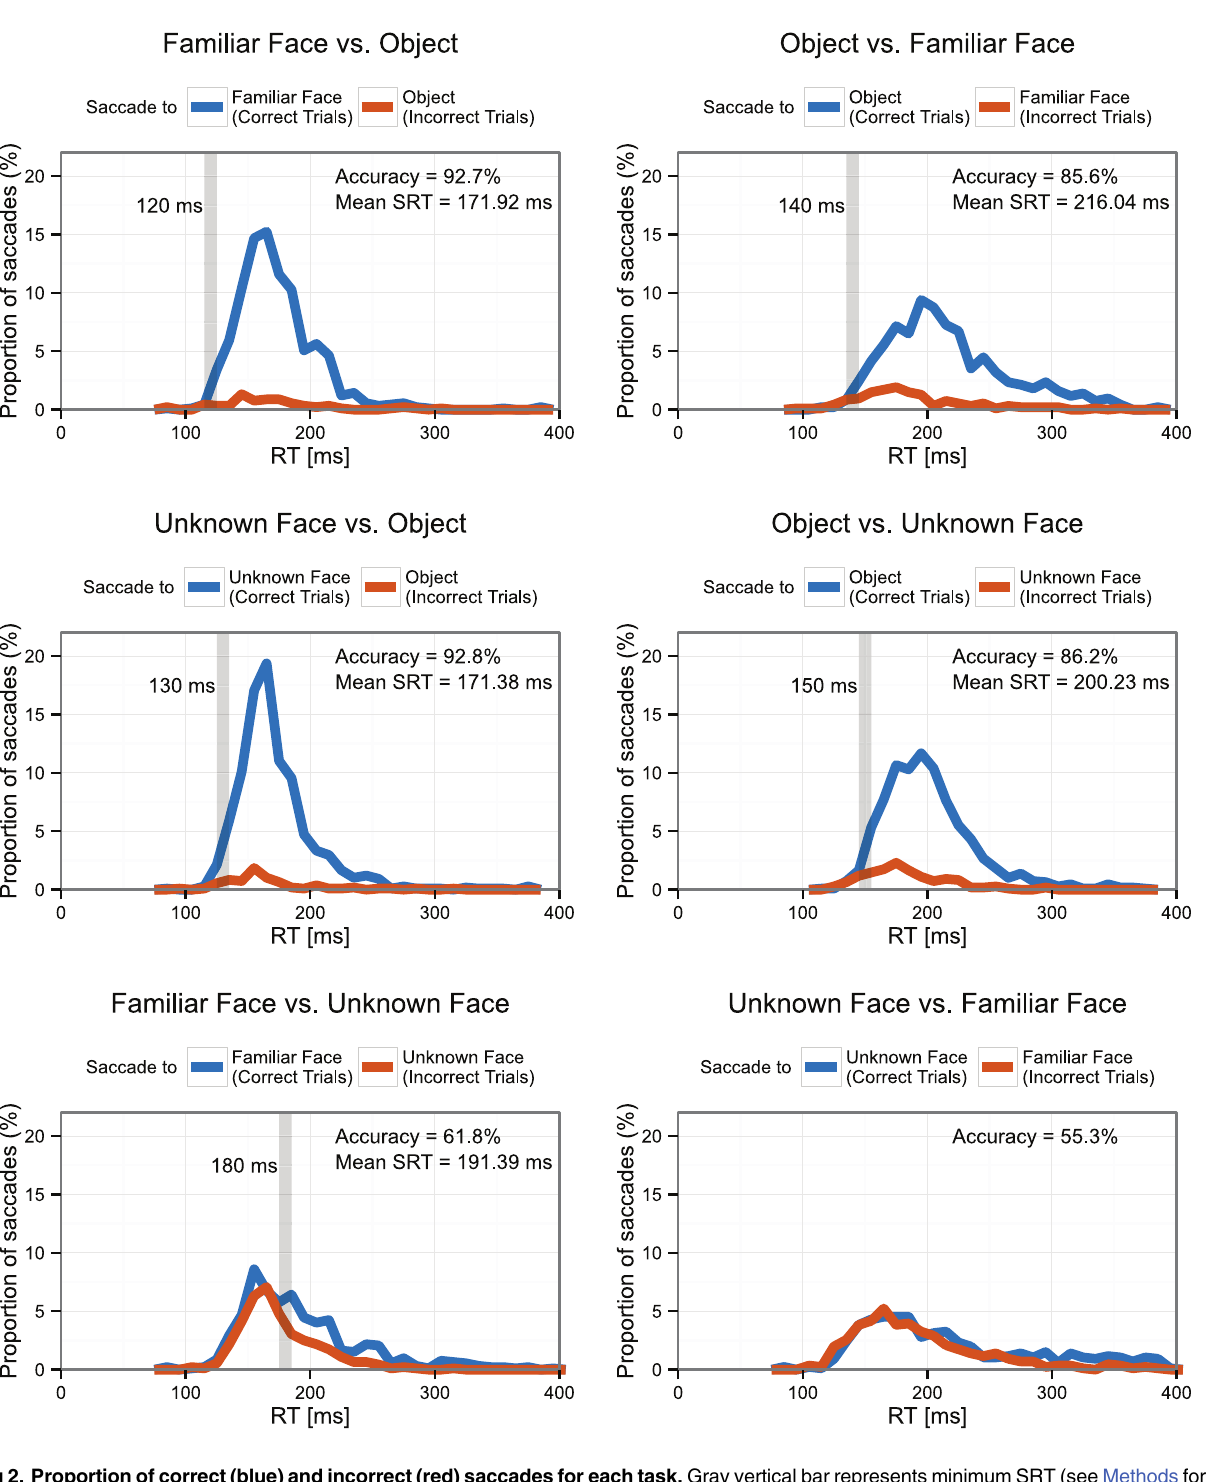
Fig 2. Proportion of correct (blue) and incorrect (red) saccades for each task. Gray vertical bar represents minimum SRT (see Methods for definition). Average SRTs are reported only for tasks significantly different from chance.